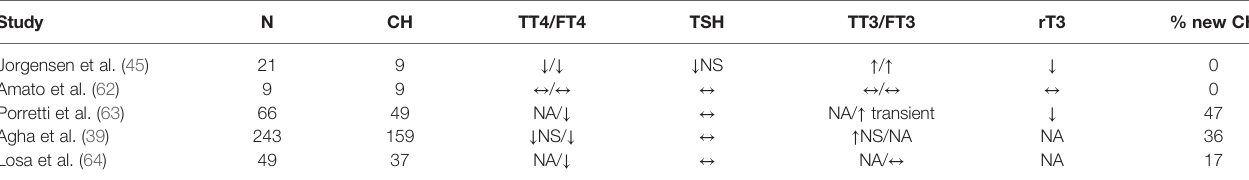
TABLE 2 | Hypothalamic-pituitary-thyroid axis changes during GH replacement therapy in AGHD. Study